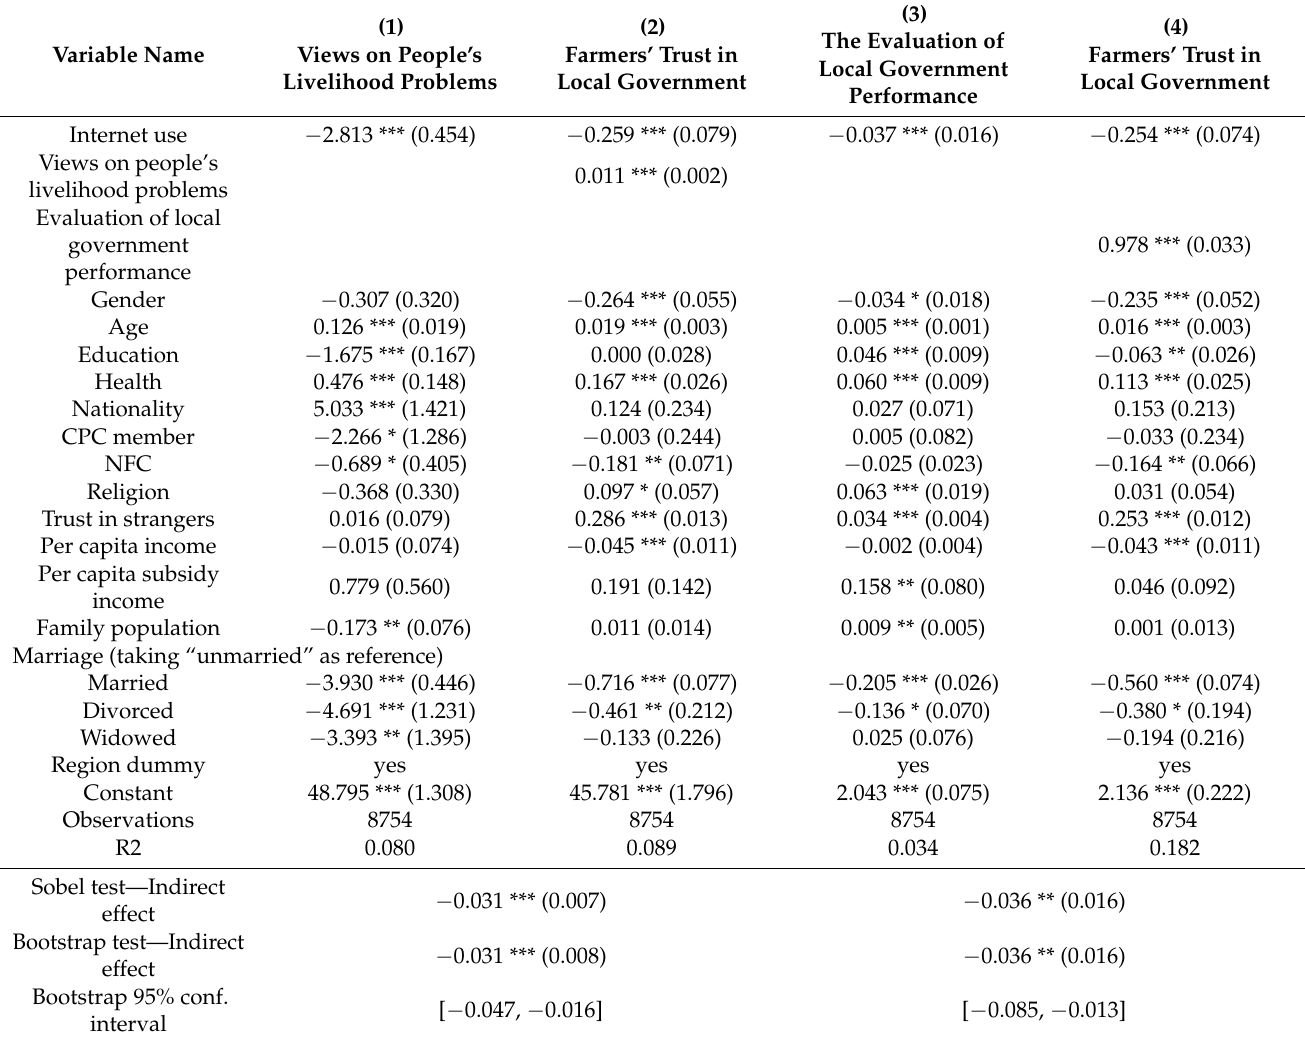
Table 6. The mediation effect of views on people’s livelihood